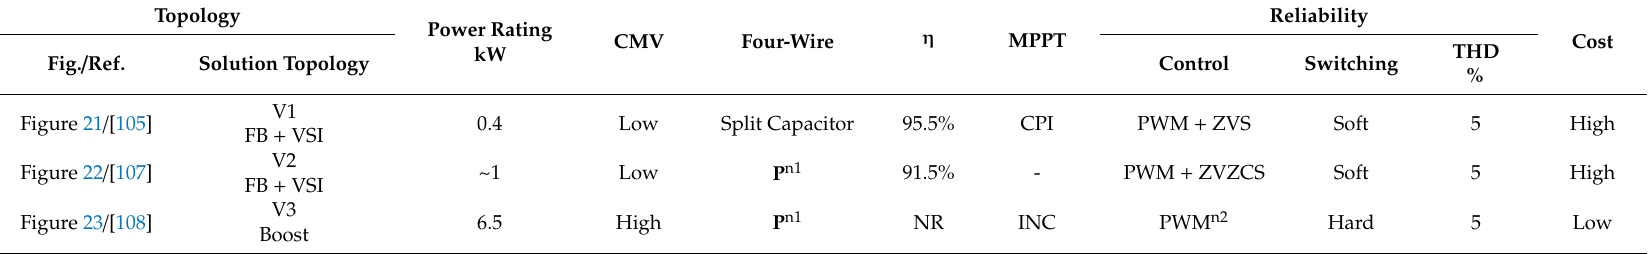
Table 5. Performance comparison for selected topologies of two-stage voltage source inverter (VSI) topologies